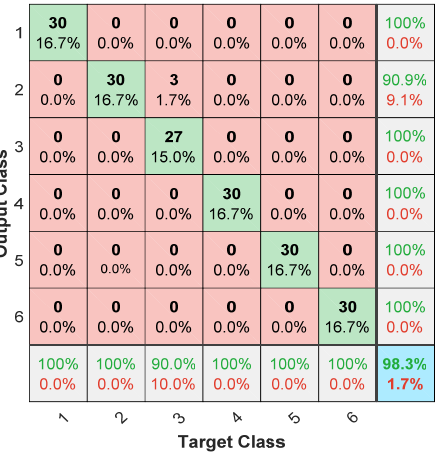
Figure 12. Confusion matrix of the IGOA-PNN recognition results.